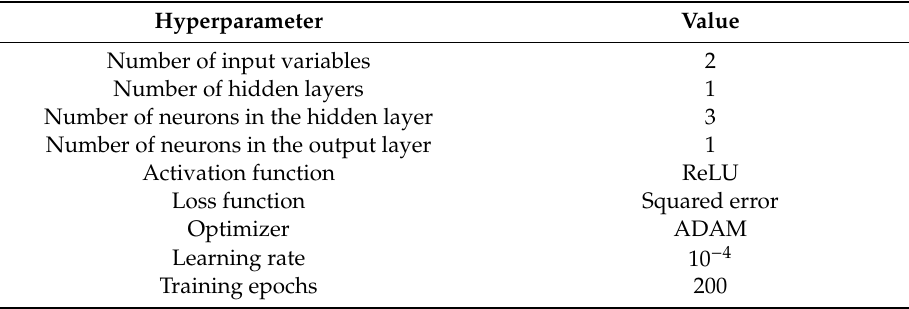
Table 2. The hyperparameters of the multilayer perceptron